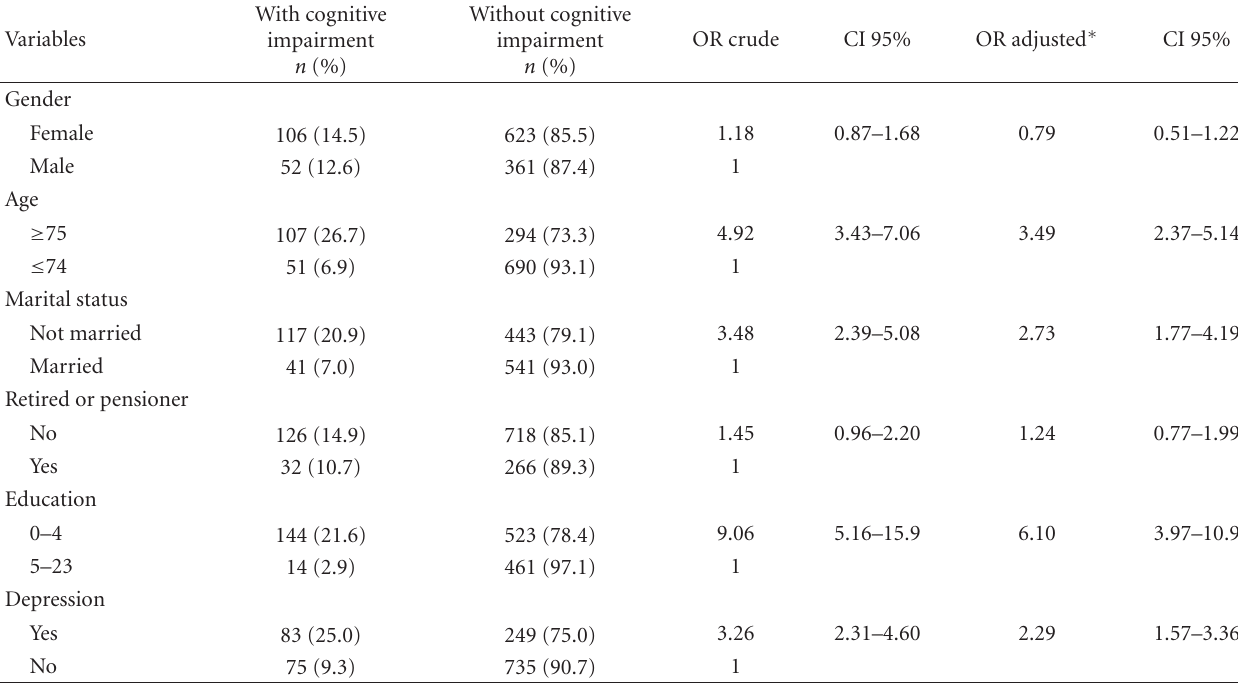
Table 3: Relationship between cognitive impairment, sociodemographic data, and depression ( n = 1142).